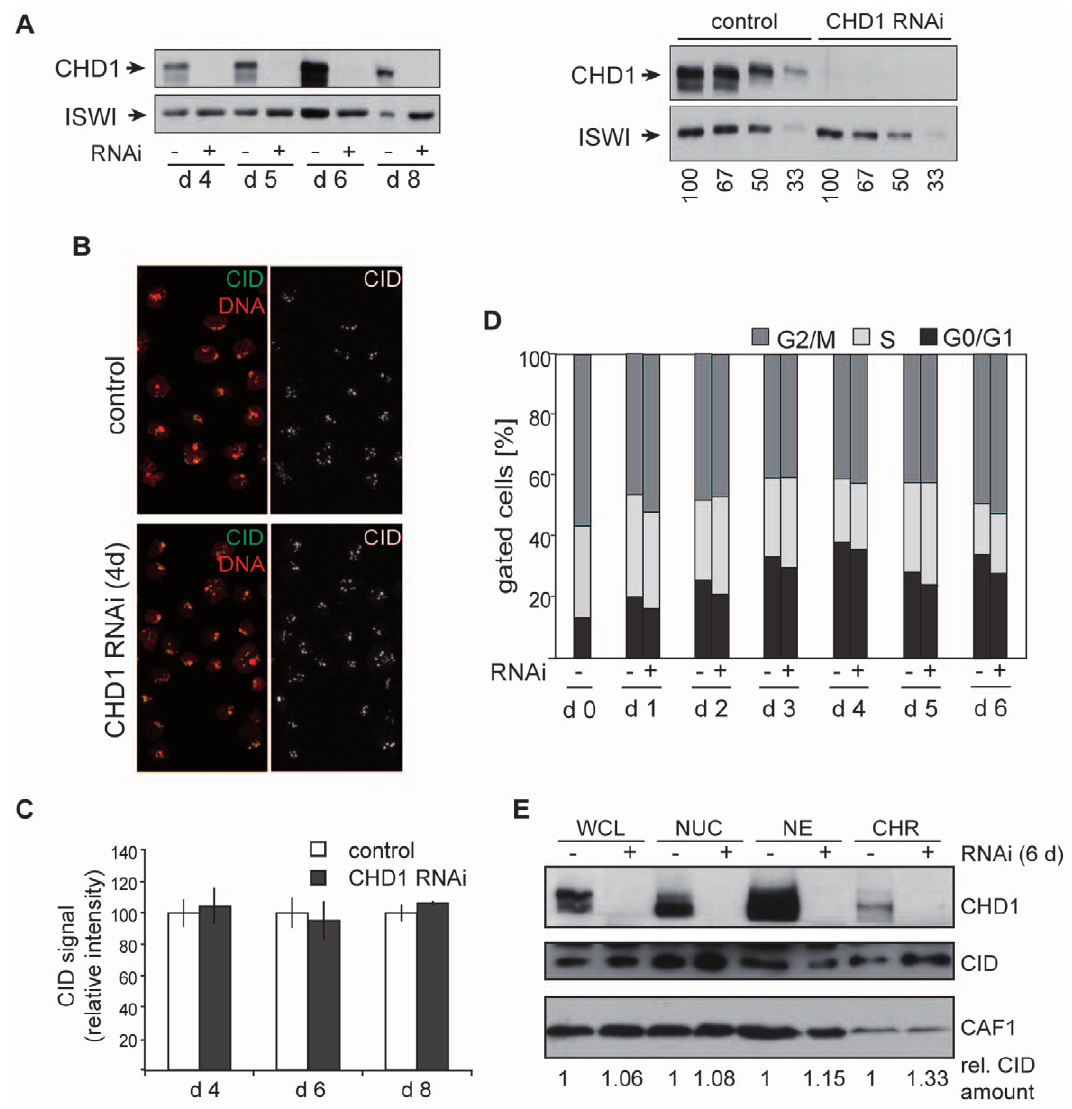
Figure 3. Cell cycle progression and CenH3 CID loading are not affected by RNAi-mediated downregulation of CHD1. A) Treatment of S2 cells with dsRNA targeting CHD1 for 4, 5, 6 and 8 days results in a decrease of CHD1 protein below detection limits. To control for equal loading western blots were incubated with an antibody against Drosophila ISWI (bottom). A serial dilution of control extracts was used to quantify CHD1 knockdown (right panel). B) CHD1 RNAi treated (4 days) and control cells were stained with anti-CenH3 CID antibodies (green). DNA was counterstained with DAPI (red). C) Signal intensities of centromeric foci after staining with anti-CenH3 CID antibodies were quantified as described in Materials and Methods. Error bars denote standard deviations of signals obtained from the following numbers of interphase nuclei: day 4 control and RNAi, n=29; day 6 control, n=168; day 6 RNAi, n=148; day 8 control, n=208; day 8 RNAi, n=169. Signal intensities remained unchanged despite extensive CHD1 depletion. D) Cell cycle profiles of CHD1 RNAi treated ( + ) and untreated ( 2 ) control cells were determined by FACS analysis at different times (days 0–6) of dsRNA incubation. No significant changes in cell cycle progression patterns are detectable. E) Immunoblot analysis of cellular fractions of control and CHD1 RNAi treated cells with antibodies against CHD1 and CID. CAF-1 p55 was used as a loading control. WCL, whole cell lysate; NUC, nuclei; NE, high salt nuclear extract; CHR, chromatin core fraction (high salt insoluble fraction). The relative amounts of CID in the different fractions remain largely unaltered after CHD1-depletion.